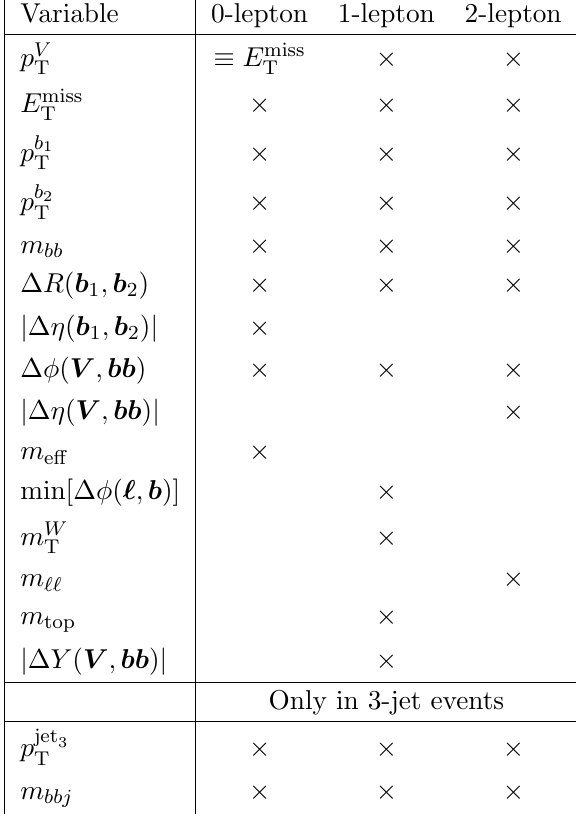
Table 5 . Variables used for the multivariate discriminant in each of the